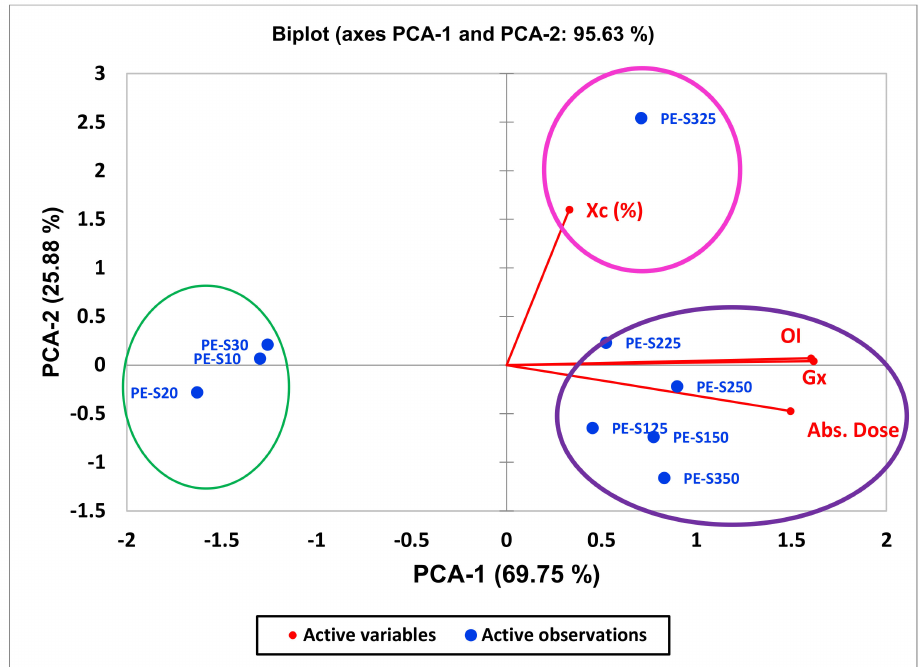
Figure 4. Bipolar PCA plot representing active variables and observations on first two